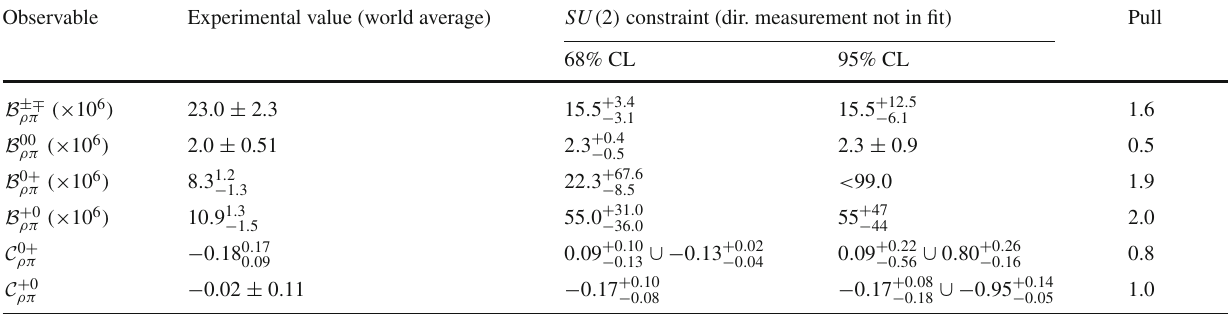
Table 16 Indirect SU ( 2 ) isospin determination of the branching fractions of the charged and neutral B → ρπ decays and direct CP asymmetries for the charged modes compared to their experimental measurement